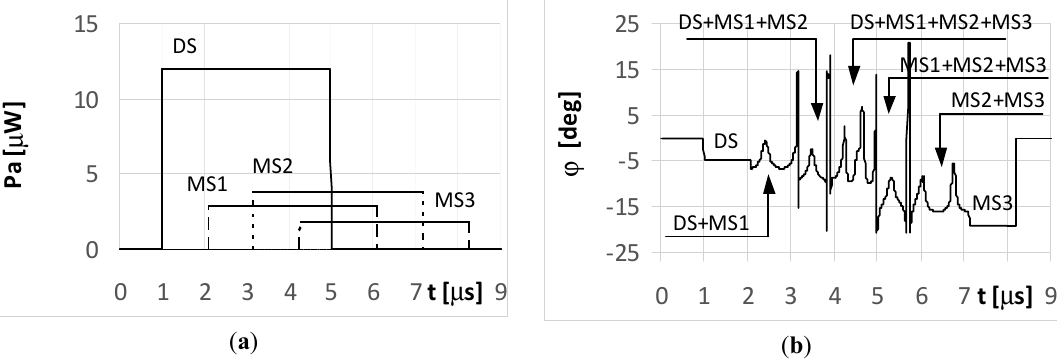
Figure 7. Envelopes of the direct signal (DS) and multipath signals (MS1, MS2, MS3) reflected from the ground, overlapping in time, and reaching UAV1 (shown in Figure 1) ( a ), and temporary angle of arrival ϕ estimated from the received resultant signal ( b ), (radar transmits simple long pulsed signal with duration t i = 4 µ s , and initial phases Φ 0D = Φ 01 = Φ 03 = 0, Φ 02 = 180 ◦ ; AOA was estimated using the monopulse phase method from the DF device installed on UAV1 ).